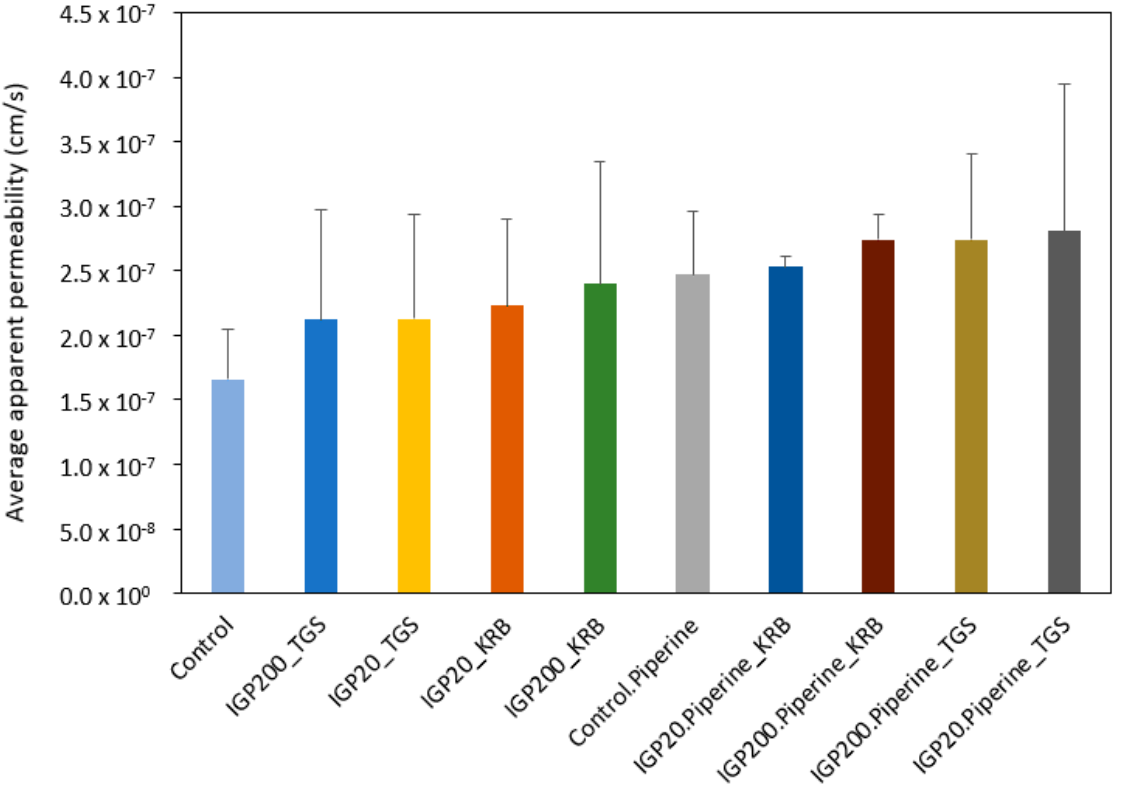
Figure 10. Average permeability coefficient values of FD-4 microparticulate formulations, with and without piperine, in Krebs-Ringer bicarbonate buffer (KRB) and nasal thermosensitive gel systems (TGS) across excised ovine nasal tissue. Data are expressed as the mean apparent permeability coefficient (P app ) values ± standard deviation; no statistically significant differences were observed, n = 6. IGP20: small microparticles (±20 µm), IGP200: large microparticles (±200 µm).